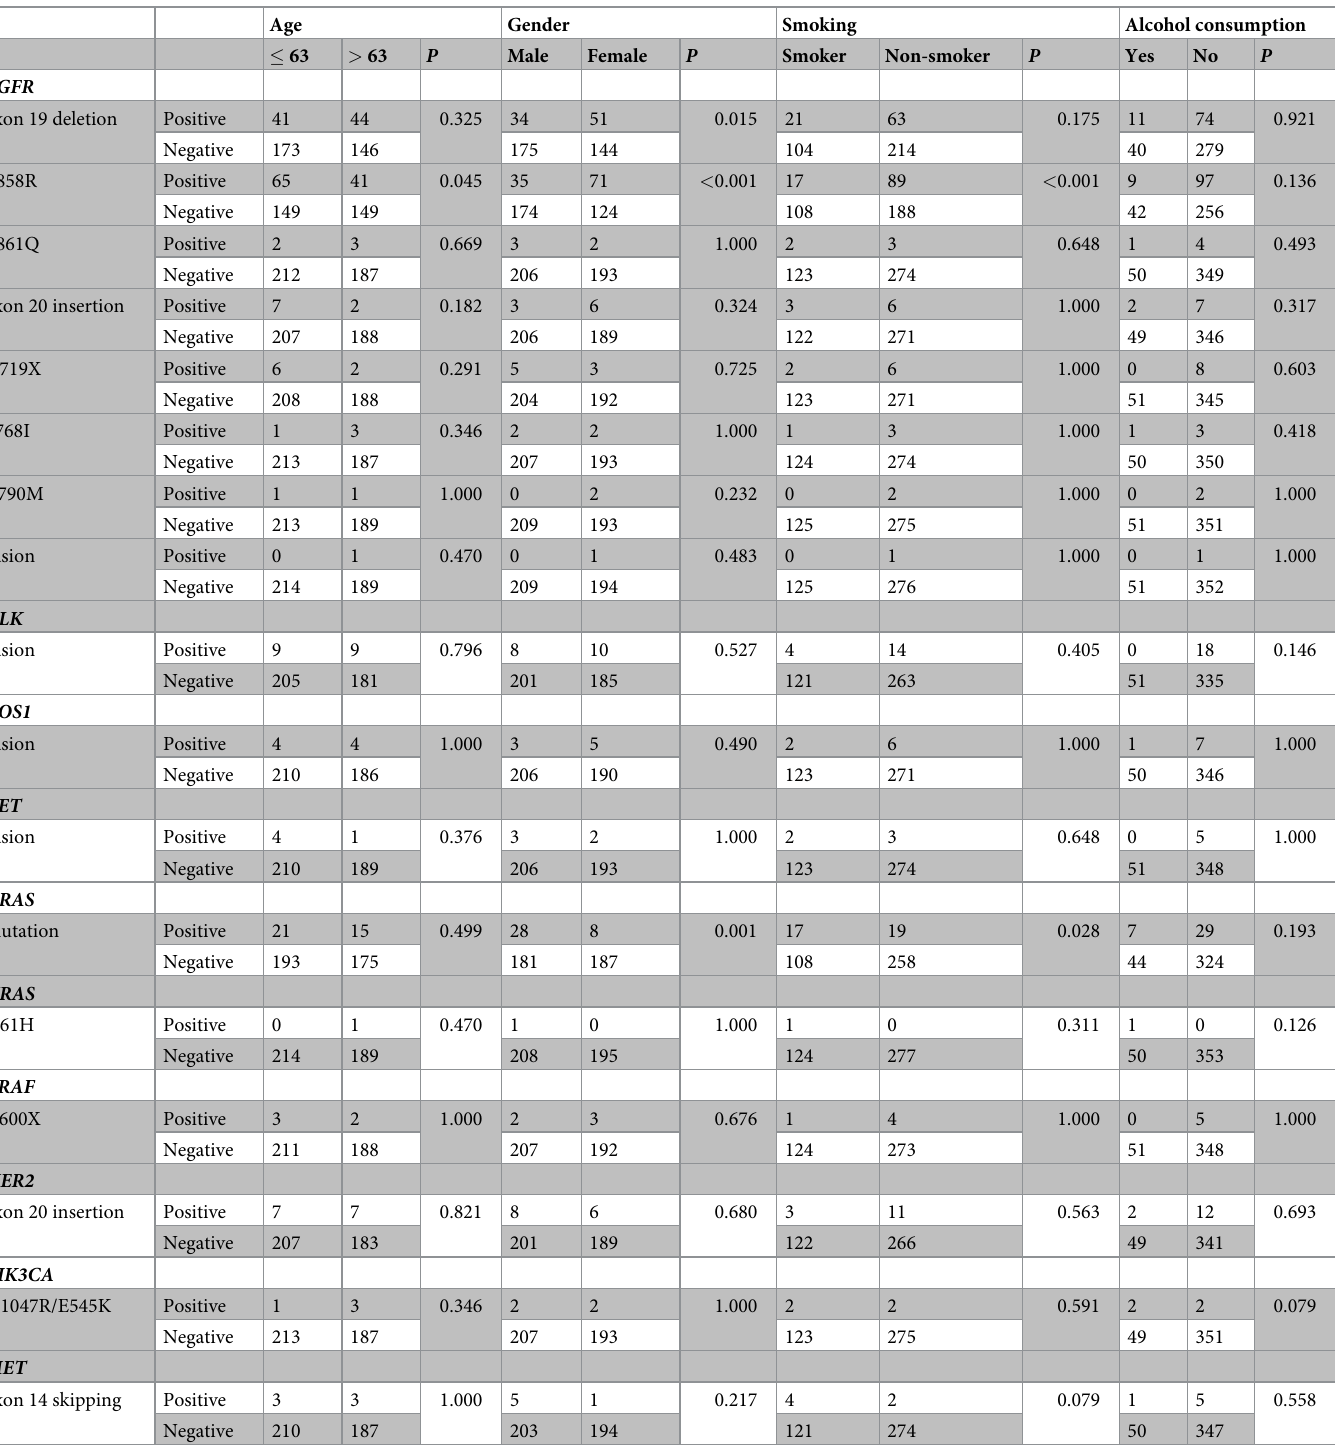
Table 3. Association between genetic variations and demographics of